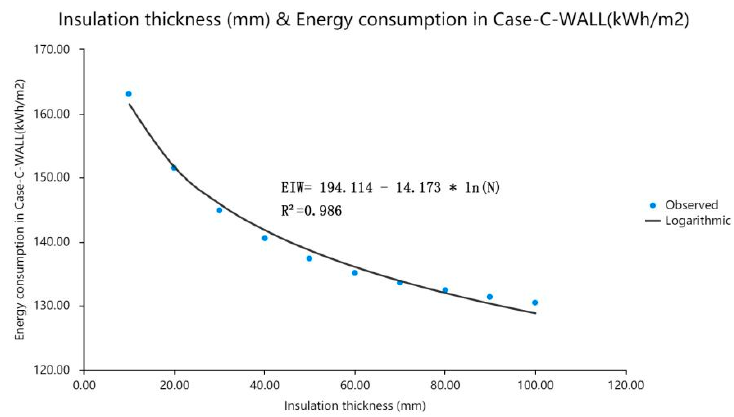
Figure 15. Logarithmic curve of EIW and N.